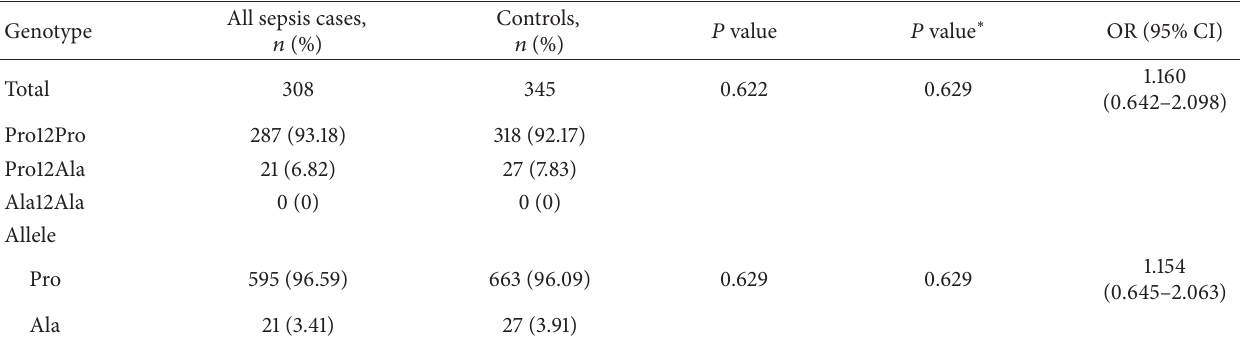
Table 2: Distributions of genotypes and allele frequencies in controls and patients with